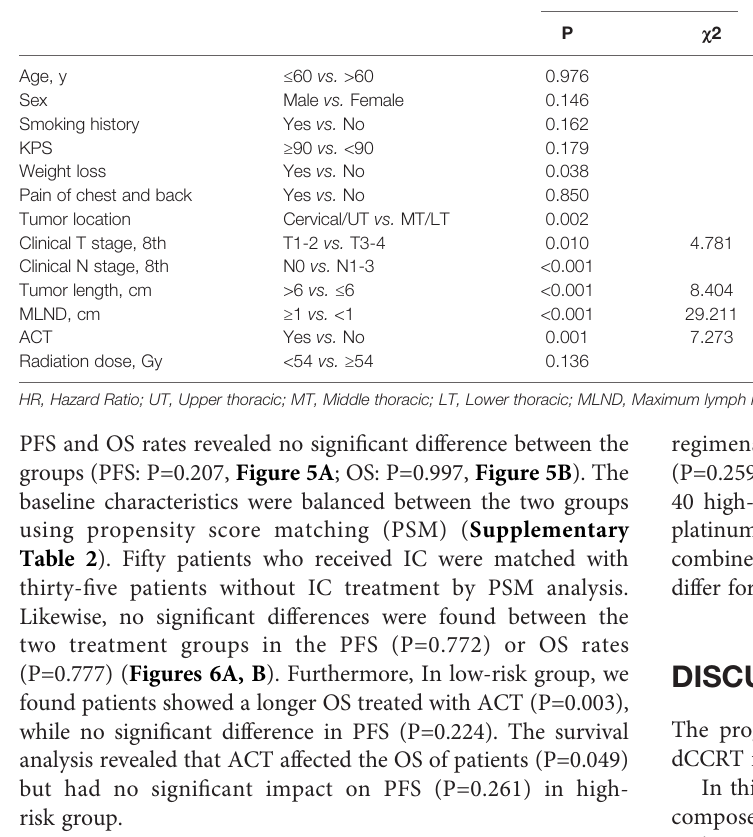
TABLE 4 | Univariate and multivariate analysis of clinical and treatment factors related to overall survival (N=599).